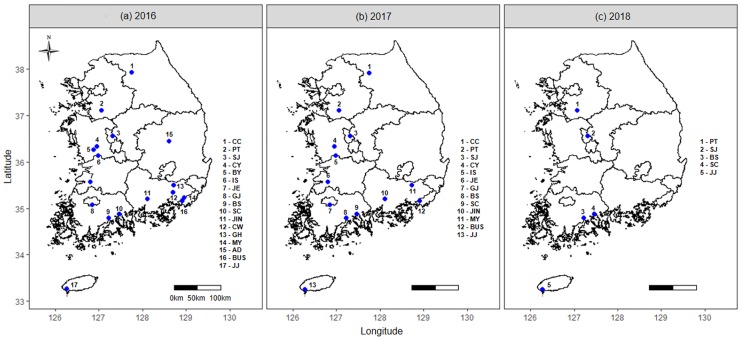
B. tabaci MED sampling sites (see Table 1 for details) in Korea from (a) 2016, (b) 2017, and (c) 2018.